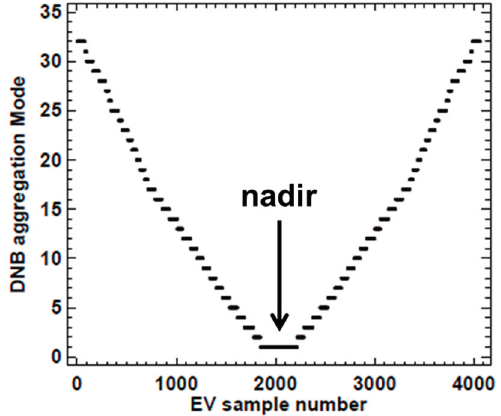
Figure 10. DNB aggregation modes vs . EV samples. The entire DNB EV consists of 4064 samples from the edge-to-edge scan angle with Sample 2032 centered at the nadir. A total of 32 aggregation modes are used to cover nadir to the edge of the scan angles, with Mode 1 being a nadir mode and Mode 32 at the edge of the scan. The FOV varies among aggregation modes, with Mode 1 being the largest FOV and Mode 32 being the smallest in order to provide near-consistent ground